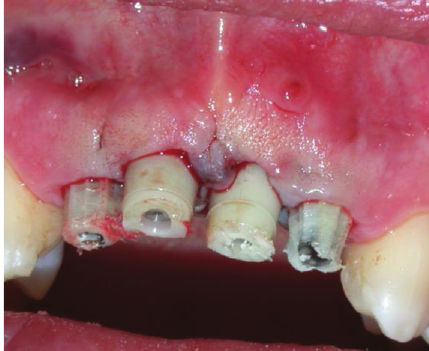
Figure 9: Polycarbonate snap-on sleeves adapted to receive tempo- rary